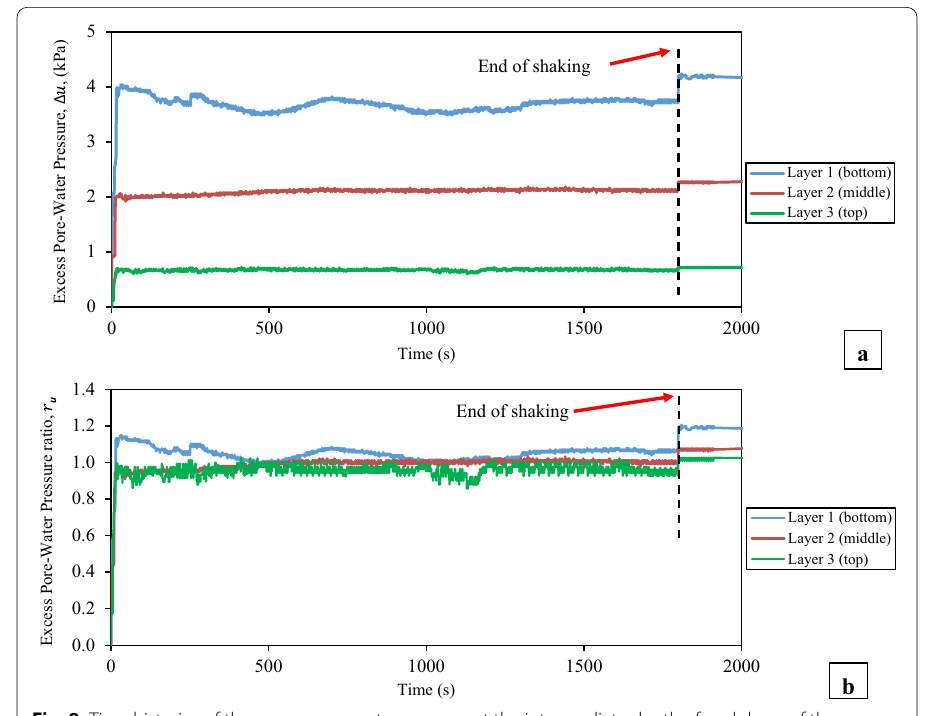
Fig. 8 Time histories of the excess pore water pressure at the intermediate depth of each layer of the thickened tailings deposit during shaking loading. a Measured excess pore water pressures (∆ u ). b